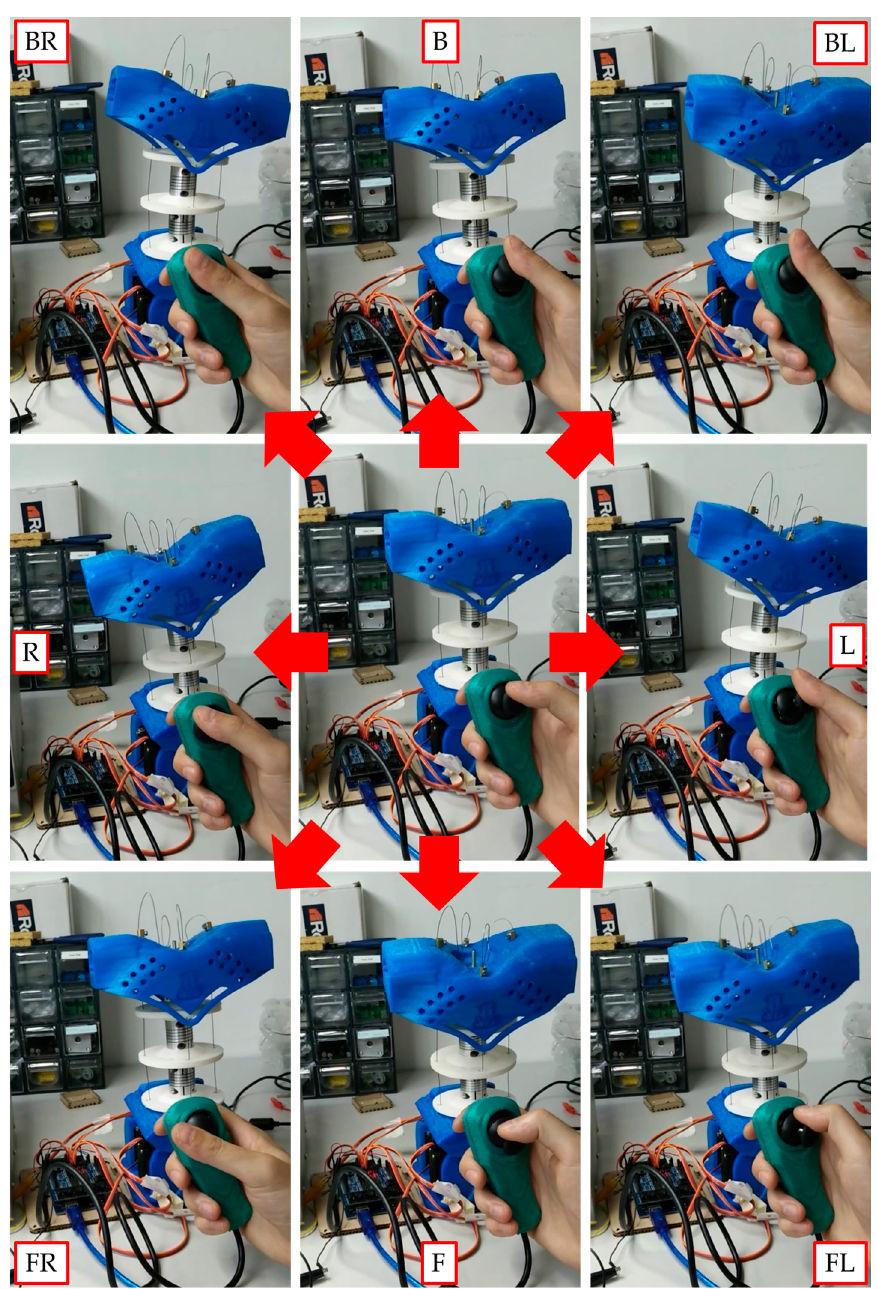
Figure 6. Motion control of the LARMbot’s torso mechanism through a joystick, with motion mapping to angle of direction and bending angle. F: forward; FL: forward-left; L: left; BL: backward-left; B: backward; BR: backward-right; R: right; FR: forward-right.